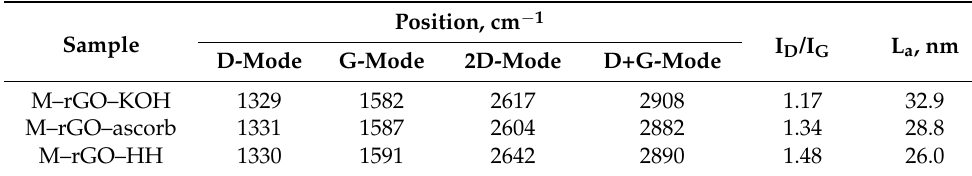
Table 2. Data obtained from Raman spectra